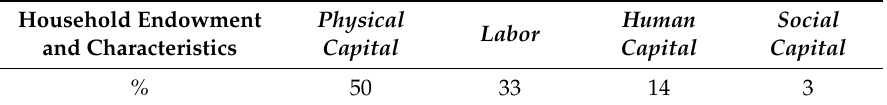
Figure 4. Micro-level drivers of land-use change (N = 330). Table 6. Decomposition of the micro-level driver: Household endowments and characteristics.